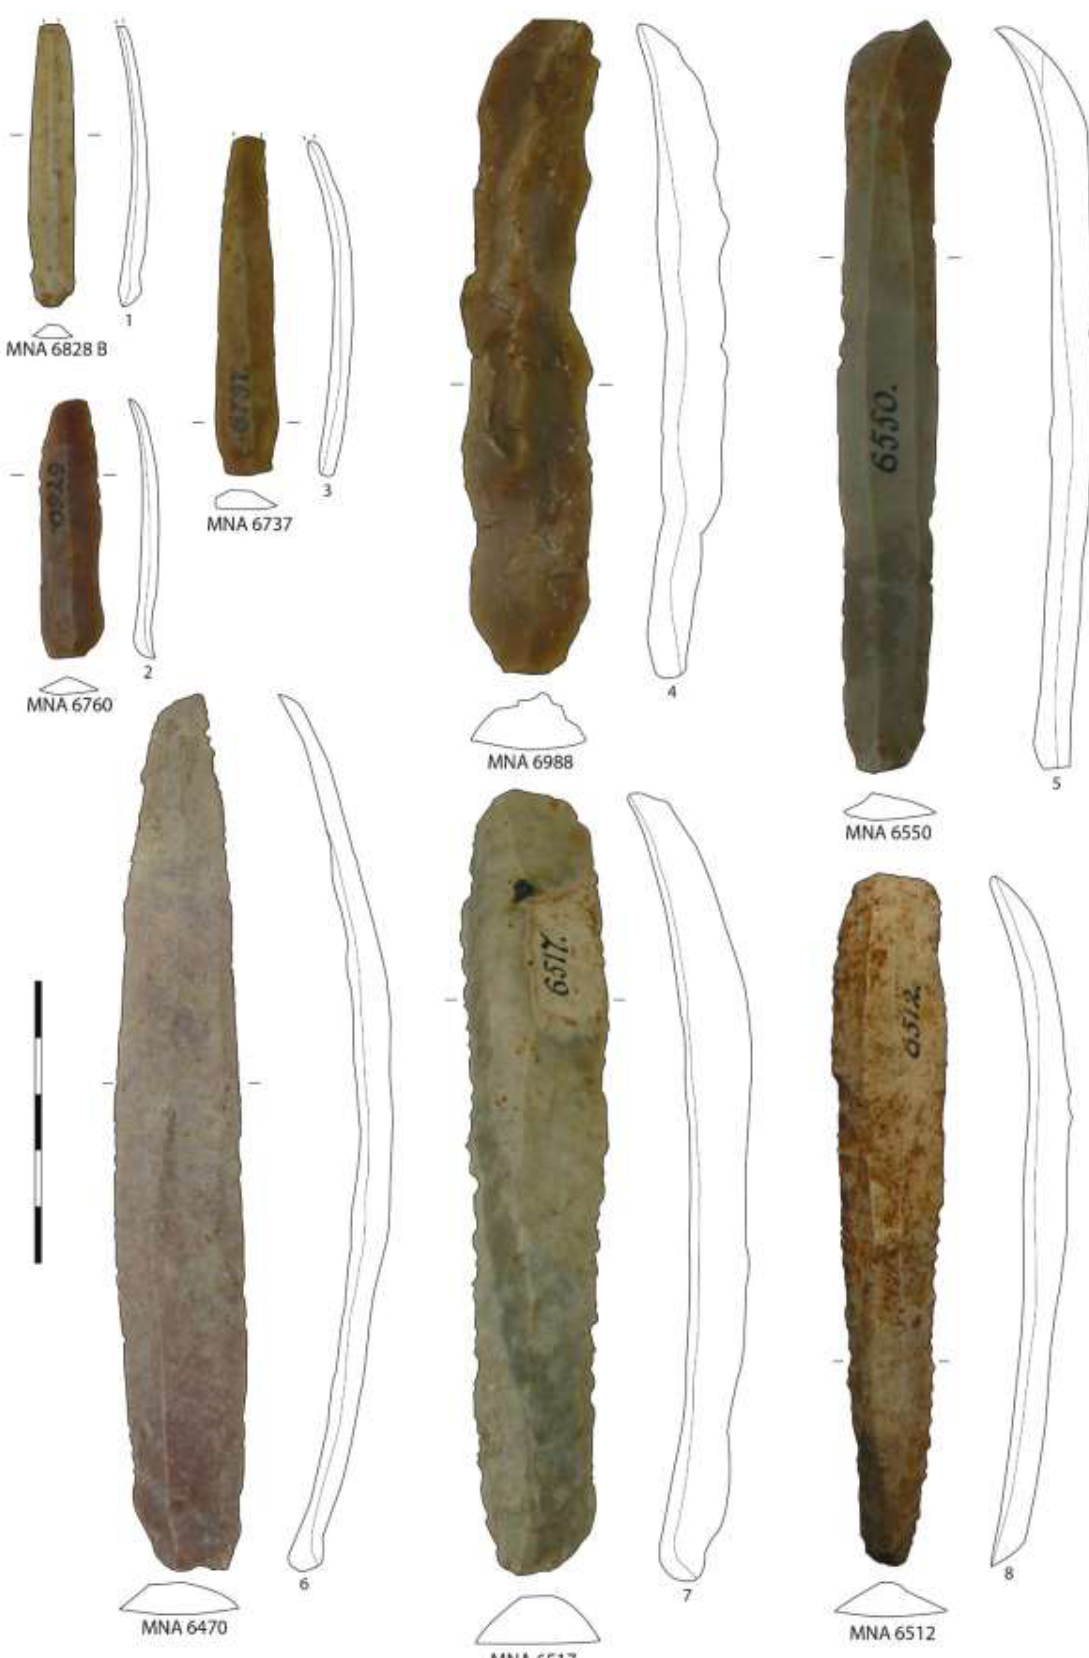
Figure 9. Blades and Bladelets: 1,3,5,6: unretouched; 2,7,8: marginal retouch; 4: crested. The scale bar is 5 cm long (in 1 cm